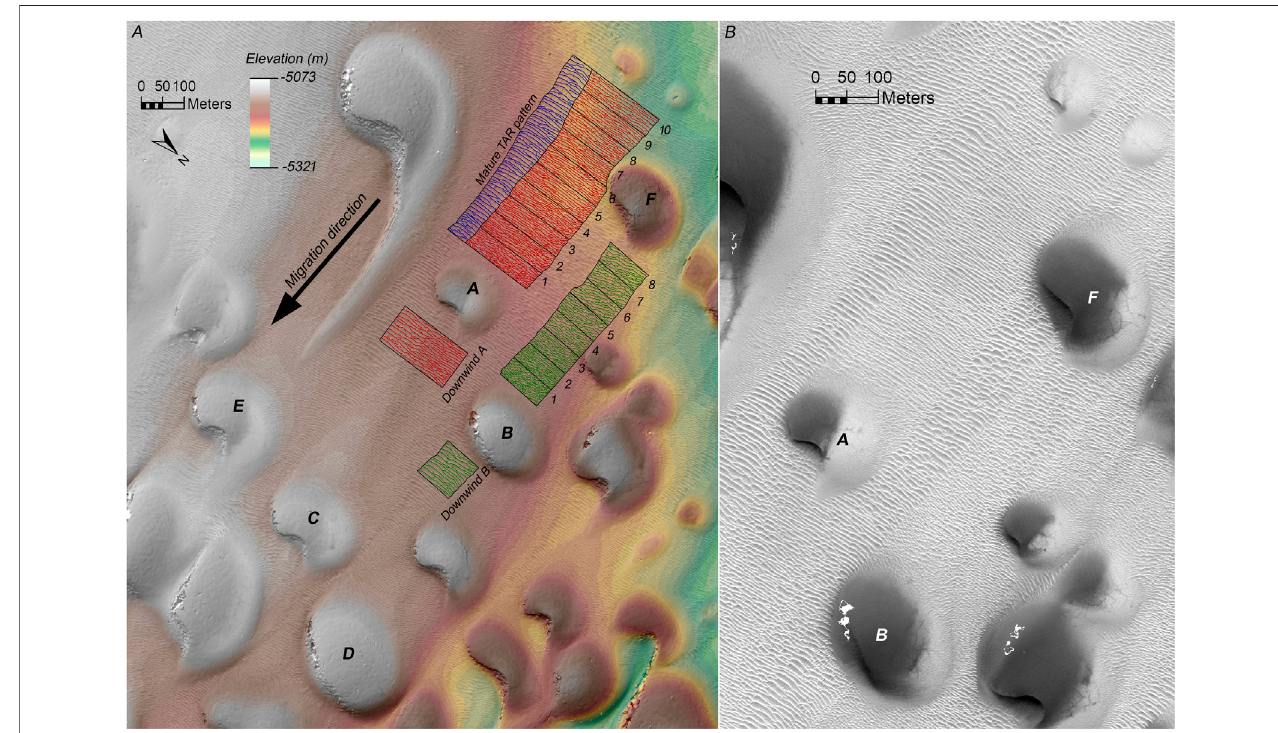
FIGURE4|(A) Orthorecti fi ed HiRISEimage ESP_044722_2570draped ontheHiRISE DTM, showingthe locationofthe studyareaand mappedcrestoutlinesfor Dunes A (red) and B (green), as well as a relatively undisturbed adjacent section of the TAR fi eld that has developed into a mature pattern (blue). The wakes were segmentedinto50-m-longpolygons,andtwo100-m-longdownwindregionsrepresenttheinitialpatternbeforebeingburiedbyDunesAandB.DuneCisdownwindof DuneA,DuneDisdownwindofthesouthernportionofDuneB,DuneEisdownwindofthemature pattern, andDuneFisdirectlyupwind ofDuneBandburies the northern part of the Dune A wake. (B) Orthorecti fi ed HiRISE image ESP_044722_2570 of the Dune A and B wakes without mapped crestlines.